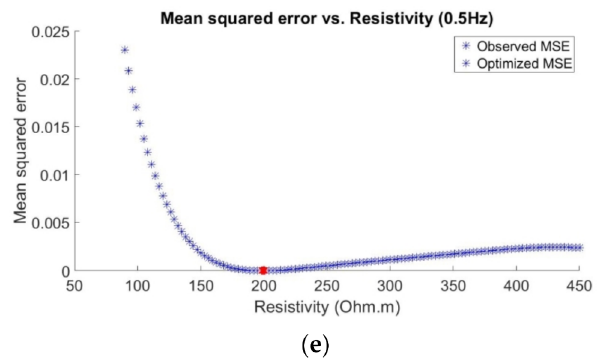
Figure 7. Mean squared error (MSE) versus hydrocarbon resistivity for multiple transmission frequencies (Observational